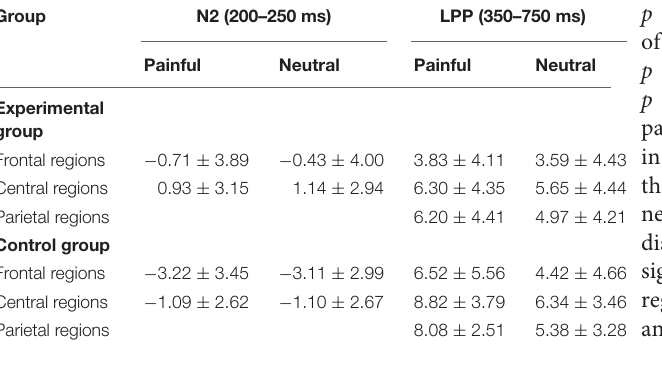
painful pictures were presented ( t = − 2.389, p < 0.05). Post hoc